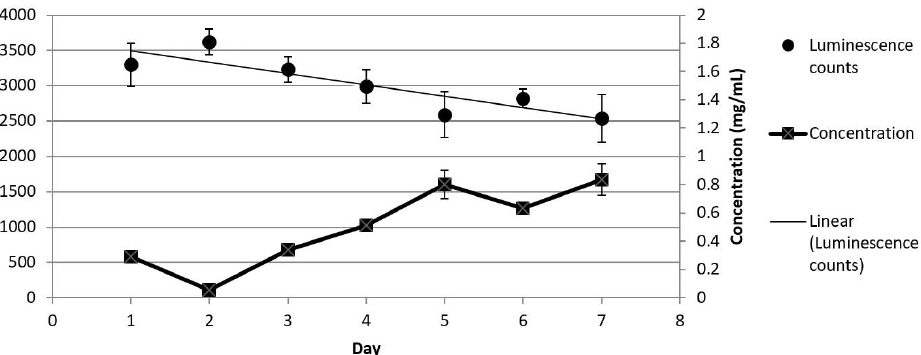
Figure 3. Quantification of bacteria lysis induced by lysozyme washes using the BacTiter kit. The bioactivity of the released lysozyme was assessed using the washes collected over seven days. The graph shows the relationship between the luminescence counts and lysozyme concentration for each day, which was determined from a standard curve of known lysozyme and its ability to lyse E. coli .